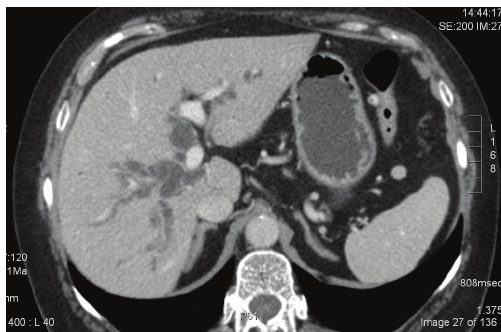
Figure 1: Initial CT scan in patient A, showing central cholangio- carcinoma with multiple satellite nodules surrounding the primary tumor.